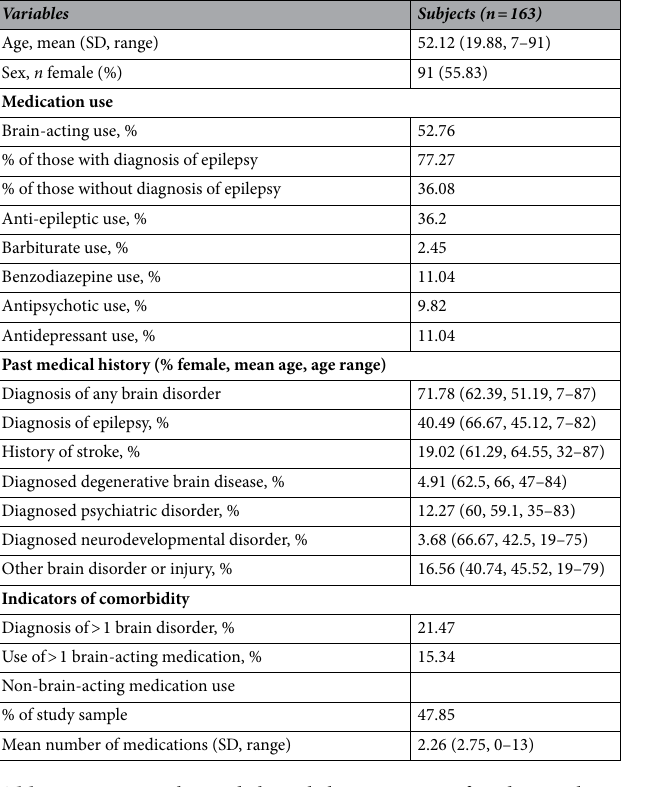
Table 1. Demographic and clinical characteristics of study sample. Brain-acting medications include anti- epileptics, barbiturates, benzodiazepines, antipsychotics, and